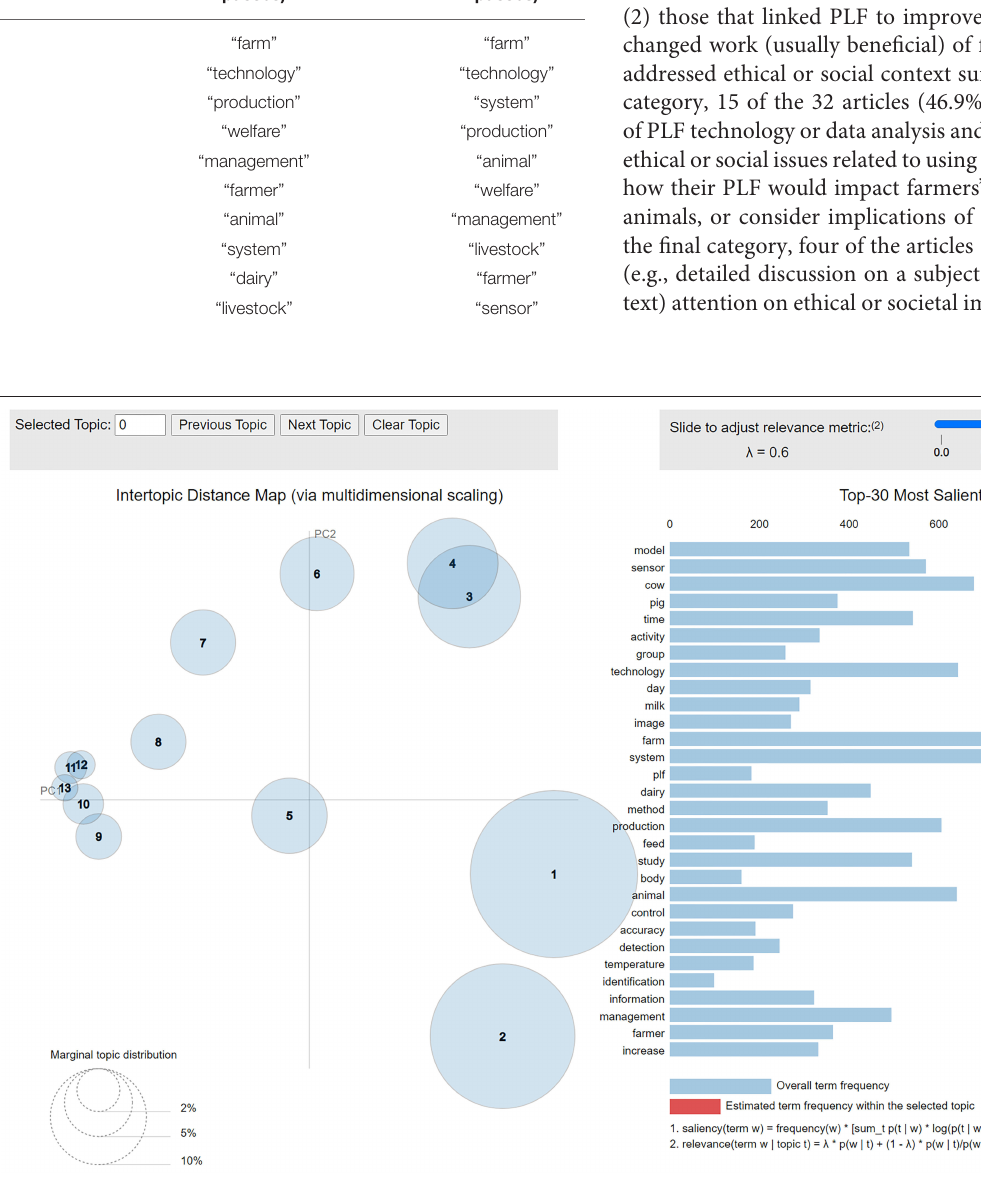
FIGURE 4 | Overview of the results produced by LDA Model 1 (50 passes, 13 topics) with the relevance metric ( λ ) set to 0.6 and no specific topic cluster selected. Topics 1 and 2 depict broader generalistic PLF clusters, Topics 3 and 4 are oriented mainly toward dairy cattle, and the remaining topics are more focused and represent pig and poultry production as well as highly specific areas such as feeding, emission control, and so forth.